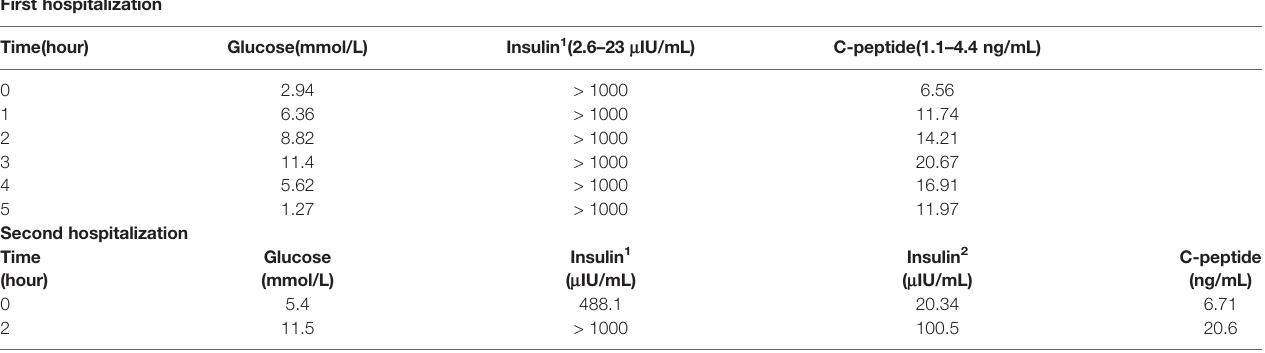
TABLE 1 | Results of oral glucose tolerance tests and insulin – C-peptide release